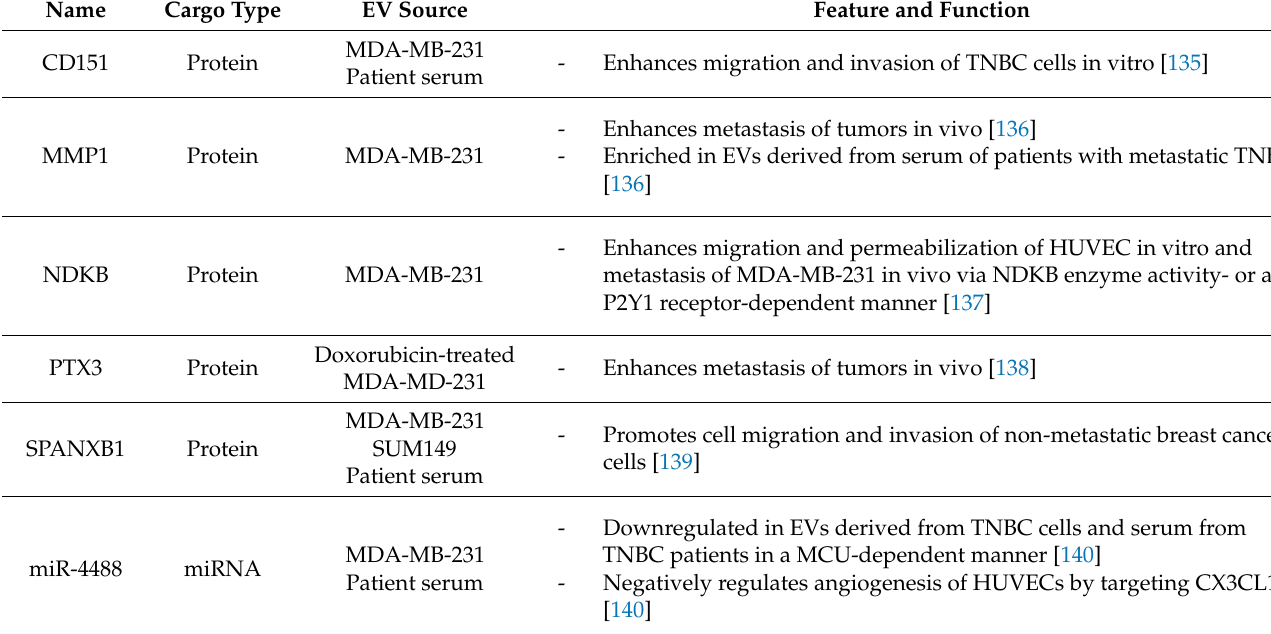
Table 3. TNBC-EV cargo involved in tumor